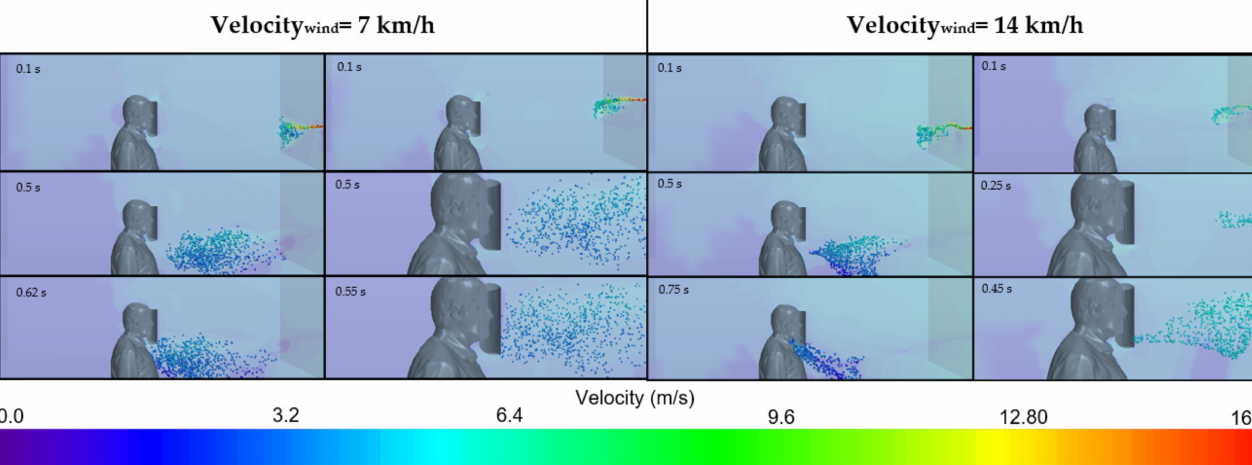
Figure 9. The velocity that the droplets acquire when the relative humidity is 60% and the ambient temperature is 15 ◦ C, at different wind speeds (soft breeze of 7 km/h and moderate wind of 14 km/h). When there was a soft breeze, the droplets reached the other human in 0.62 s and 0.55 s when the human mouths were at the same height and with a height difference of 20 cm, respectively. When there was a moderate wind speed, the droplets reached the other human in 0.0.75 s and 0.45 s when the human mouths were at the same height and with a height difference of 20 cm,